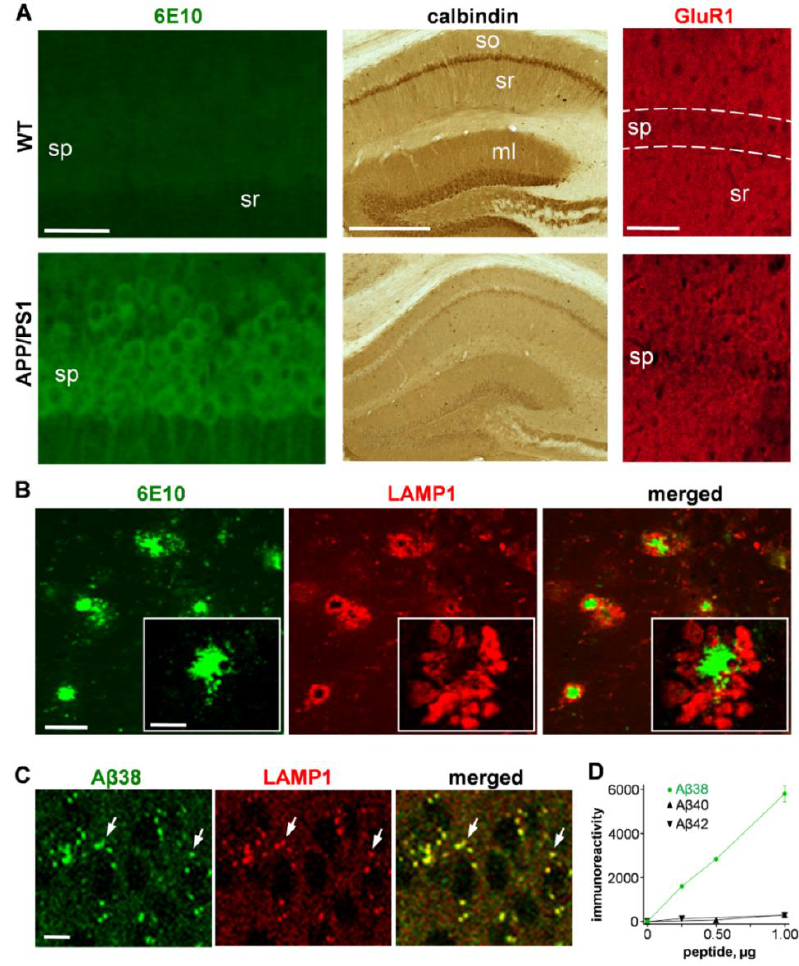
Figure 1. Proteinopathy in amyloid precursor protein / presenilin-1 (APP / PS1) transgenic mice is linked to alterations in neuronal lysosomes . Fixed tissue sections from 22–23 month-old APP / PS1 mice and age-matched wild-type littermates (WT) were immunostained with the 6E10 antibody to amyloid β 1–16 (A β 1–16; green; size bar: 30 µ m), anti-calbindin (middle; size bar: 500 µ m), and anti-glutamate receptor 1 (GluR1; red; size bar: 50 µ m) to monitor accumulation of potentially amyloidogenic material and synaptic pathology ( A ). ml, molecular layer; so, stratum oriens; sp, stratum pyramidale; sr, stratum radiatum. APP / PS1 hippocampal tissue was also double-labeled and images were captured of 6E10-positive deposits (green) surrounded by lysosome-associated membrane protein 1 (LAMP1) staining (red), indicating severely swollen lysosomes accumulated at amyloid plaques ( B , size bar: 50 µ m; insert size bar: 10 µ m). In immunostained transgenic tissue, A β 38 (green) and LAMP1 (red) were colocalized in lysosomes ( C ; size bar: 10 µ m) found within hippocampal neurons (see arrows). To confirm the specificity of the anti-A β 38 antibody, increasing amounts of three A β peptides were assessed by an ELISA protocol using anti-A β 38 for detection ( D ).